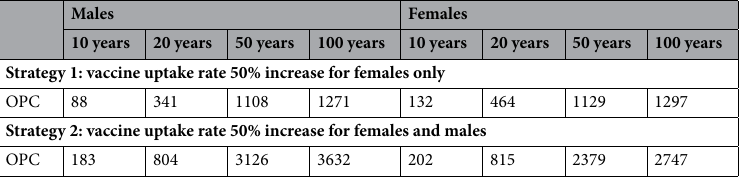
of disease among men were prevented; for example, 2362 cases among men and 1450 cases among women were prevented after 100 years of vaccination. Additionally, more cases expected prevented with a longer follow-up